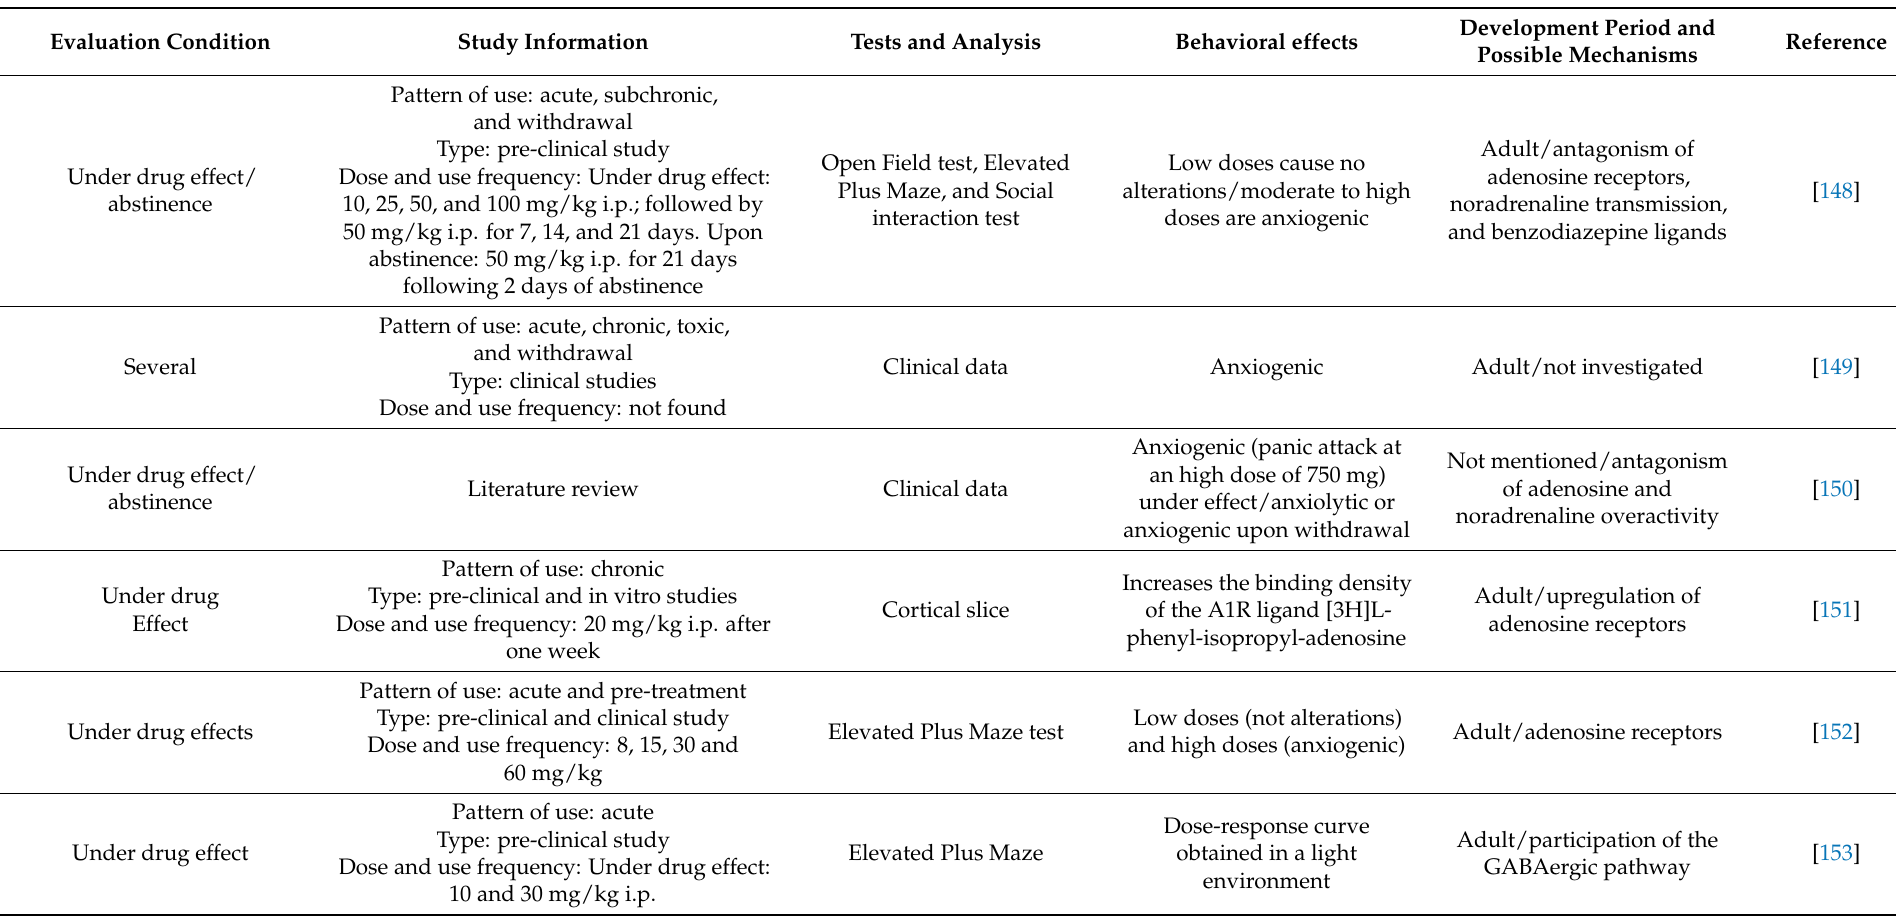
Table 2. Caffeine, adenosinergic system, and